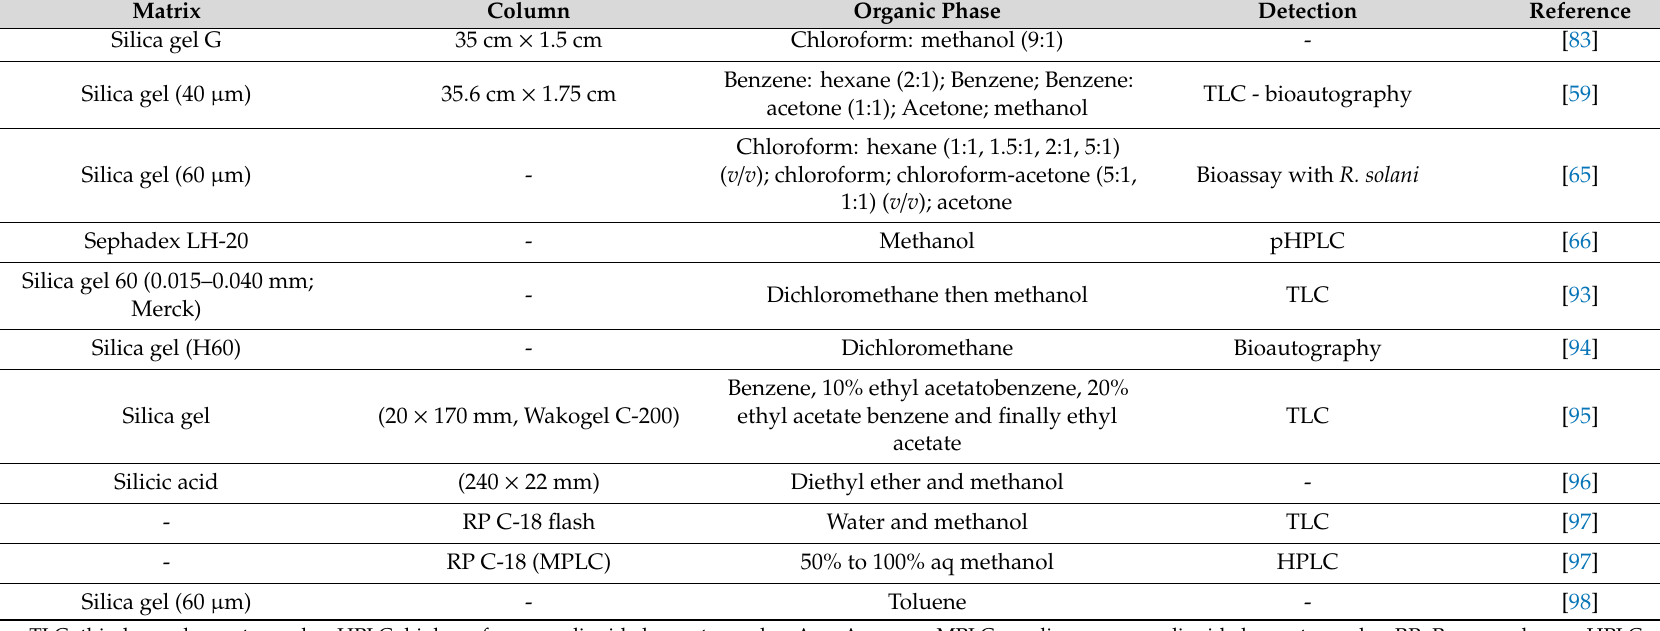
Table 4. Purification of pyrrolnitrin using various separation techniques with di ff erent solvent